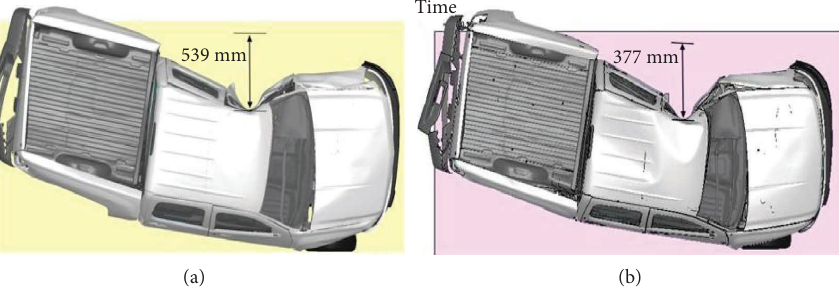
Figure 15: Structural response of the existing and modifed model.